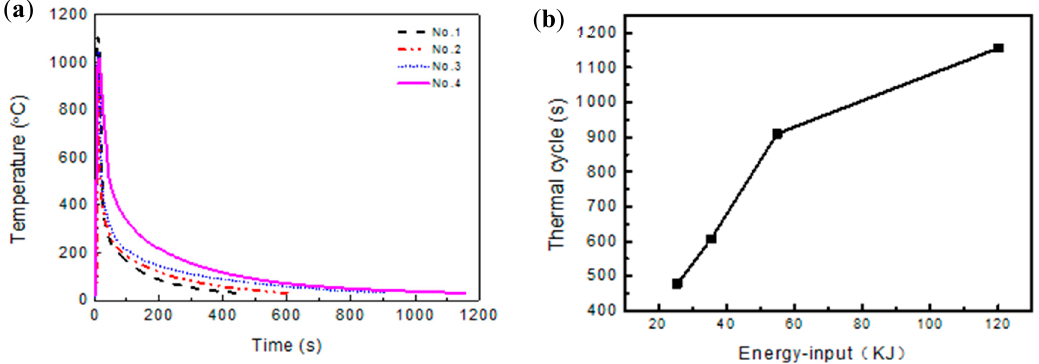
Figure 5. The evolution of ( a ) temperature during RFW process and ( b ) cycle time with energy-input.